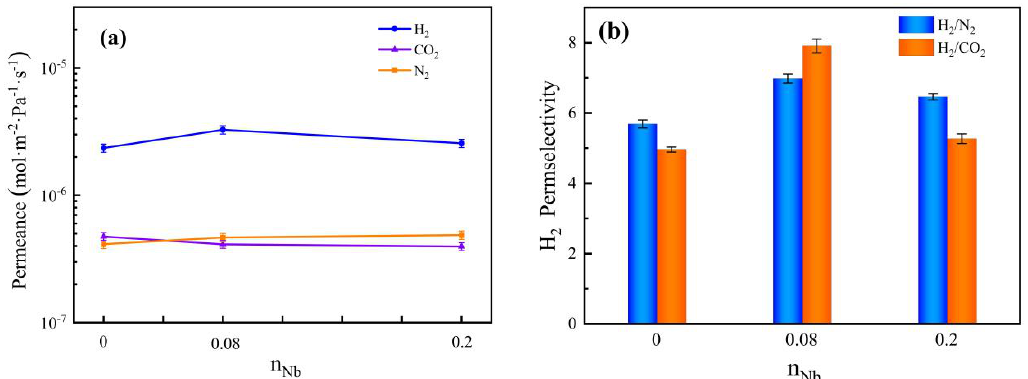
Figure 13. Effect of n Nb on ( a ) gas permeance and ( b ) H 2 permselectivity of Nb/SiO 2 membrane at a pressure difference of 0.1 MPa and 25 °C.